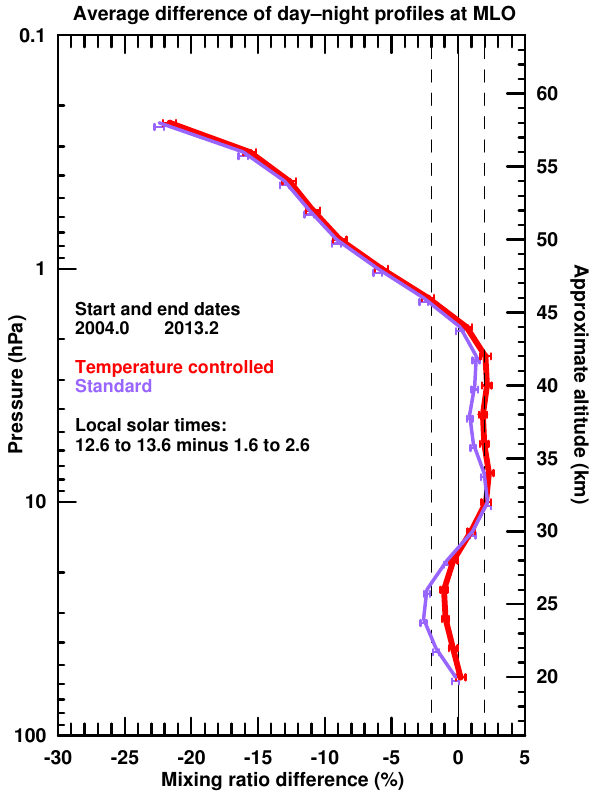
Figure 2. Day–night difference profiles derived from data that were recorded when the room temperature was well controlled and the signal beam elevation angle was within specified limits, as follows: black; selected data, as used for this work, with elevation angle >13.5 ◦ ; red, no angle limits, corresponding to the red profile in Fig. 1; green, 11.5 to 12.5 ◦ ; blue, >14.5 ◦ . Errors and other details are as described in the caption for Fig. 1. See text for discussion of the